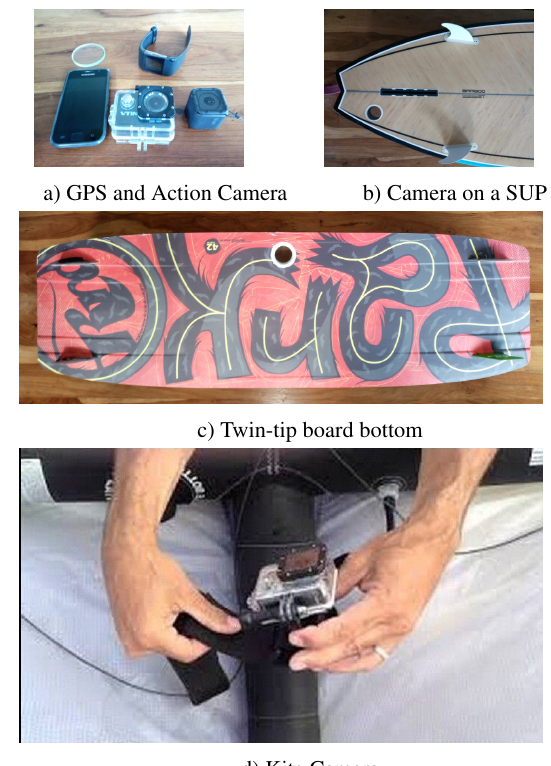
Figure 2. Setting up cameras on boards or on the